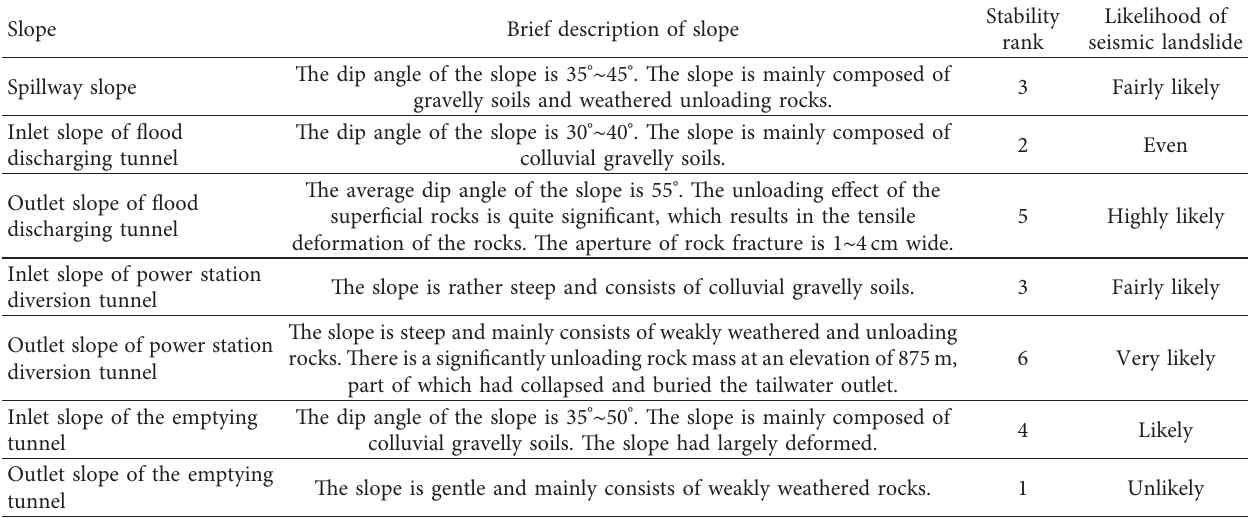
Table 2: Ranks of slope stability and linguistic descriptions of the likelihood of a seismic landslide.